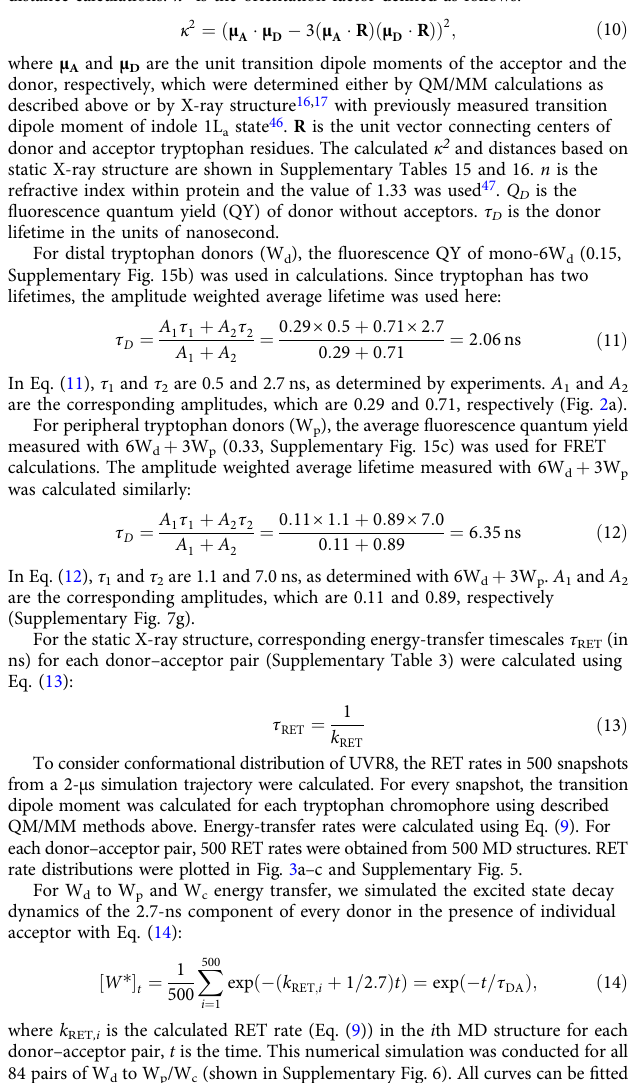
where k RET ,i is the calculated RET rate (Eq. (9)) in the i th MD structure for each donor – acceptor pair, t is the time. This numerical simulation was conducted for all 84 pairs of W d to W p /W c (shown in Supplementary Fig. 6). All curves can be fi tted well with single-exponential decay with various time constants ( τ DA ) as labeled in Supplementary Fig. 6. The effective RET time constant was obtained as: The resulting energy-transfer timescales τ RET (in ns) are shown in Supplementary Table